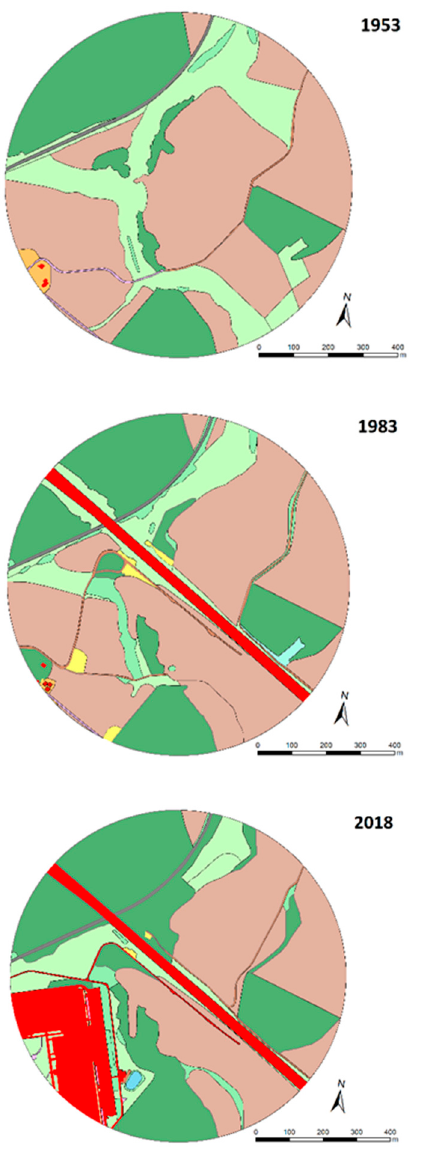
Figure 5. Land cover development at Site A.